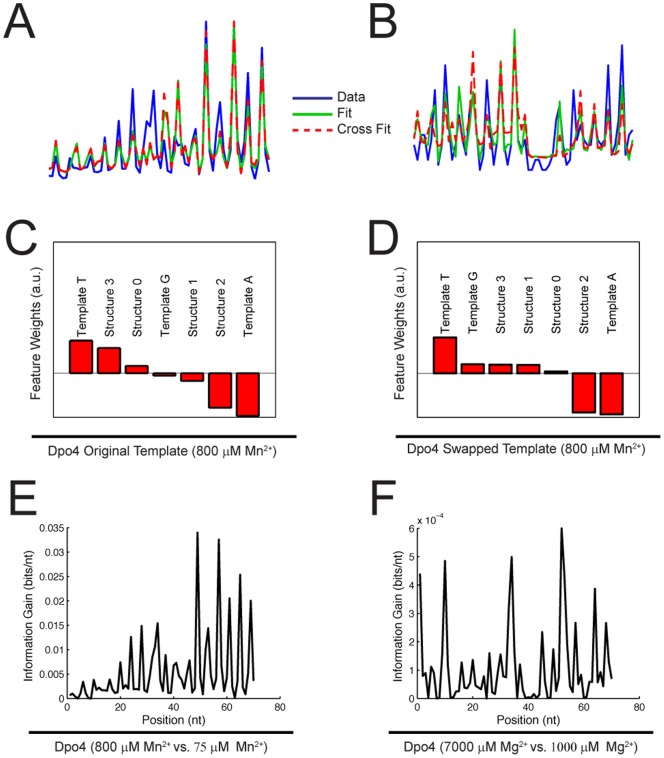
Statistical analysis of misincorporation by Dpo4.(A) Spatial dependence (un-normalized) of Dpo4 error rate at 800 µM Mn2+ on the original template (blue curve), and generalized linear model fits of this data set with respect to itself (green curve), and with respect to the swapped template data set (red curve). (B) Spatial dependence (un-normalized) of Dpo4 error rate at 800 µM Mn2+ on the swapped template (blue curve), and generalized linear model fits of this data set with respect to itself (green curve), and with respect to the original template data set (red curve). (C) Feature weights for generalized linear model fit to Dpo4 original template data. (D) Feature weights for generalized linear model fit to Dpo4 swapped template data. (E) Information gain per base as a function of template position, for discrimination between high (800 µM) and low (75 µM) Mn2+ by Dpo4. (F) Information gain per base as a function of template position, for discrimination between high (7000 µM) and low (1000 µM) Mg2+ by Dpo4.